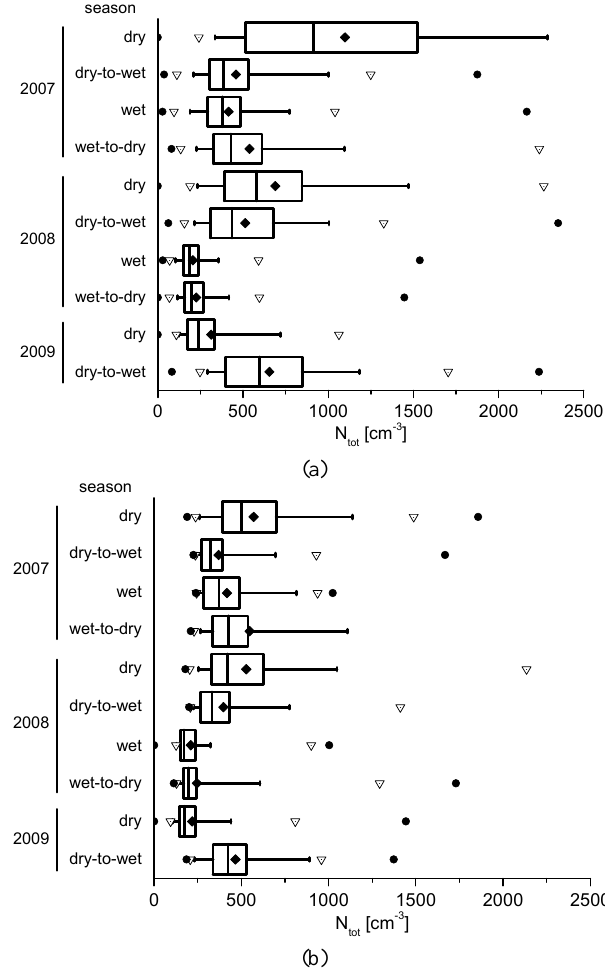
Fig. 2. Box-and-whisker plots of total particle number concen- tration (10–470nm) at Pico Espejo: (a) humid free troposphere (50% ≤ RH ≤ 95%), (b) dry free troposphere (RH < 50%). In the plots, boxes indicate the 25th, 50th and 75th percentiles. Diamonds indicate arithmetic mean, downward triangles the 5th and 95th per- centiles, and circles minimum and maximum